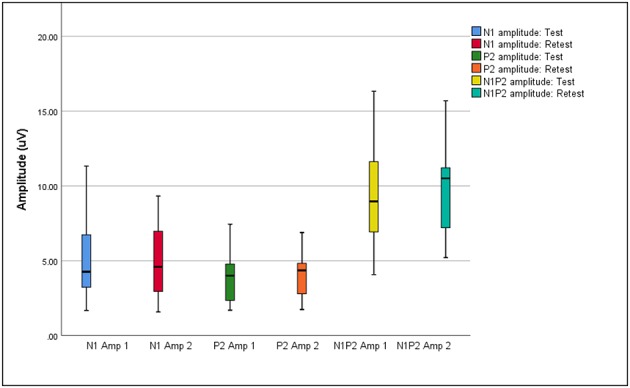
Median, interquartile range, minimum, and maximum N1, P2, and N1P2 amplitudes at test and retest (n = 12).